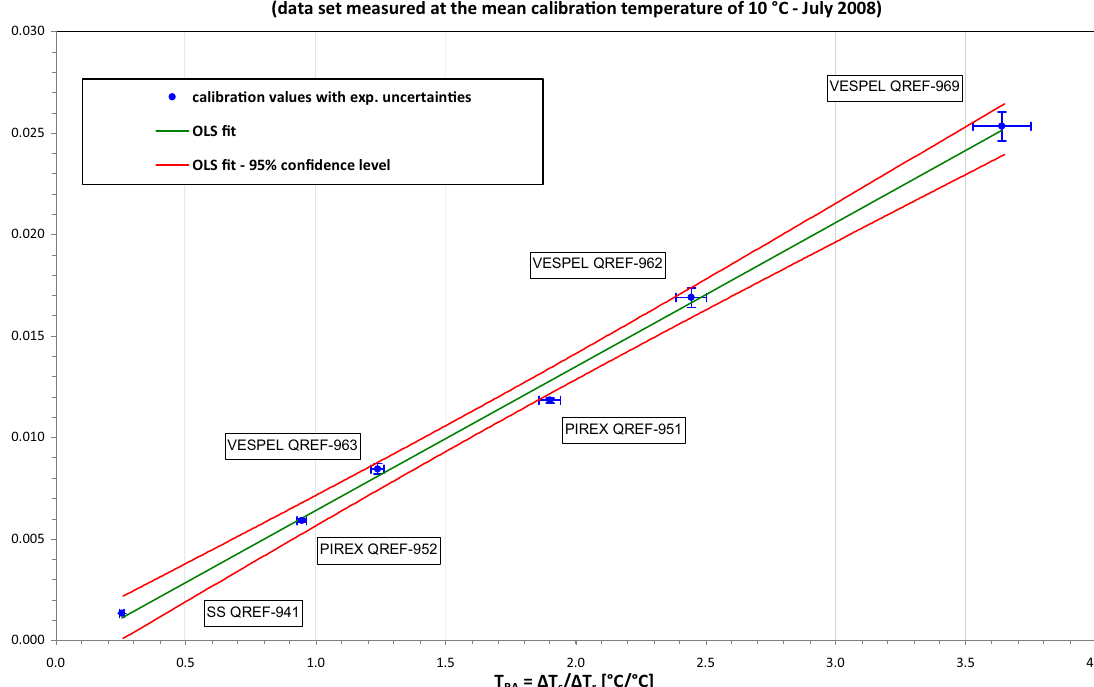
Fig. 5. (Color online) Fit of the calibration data by OLS method and construction of the confidence bands.